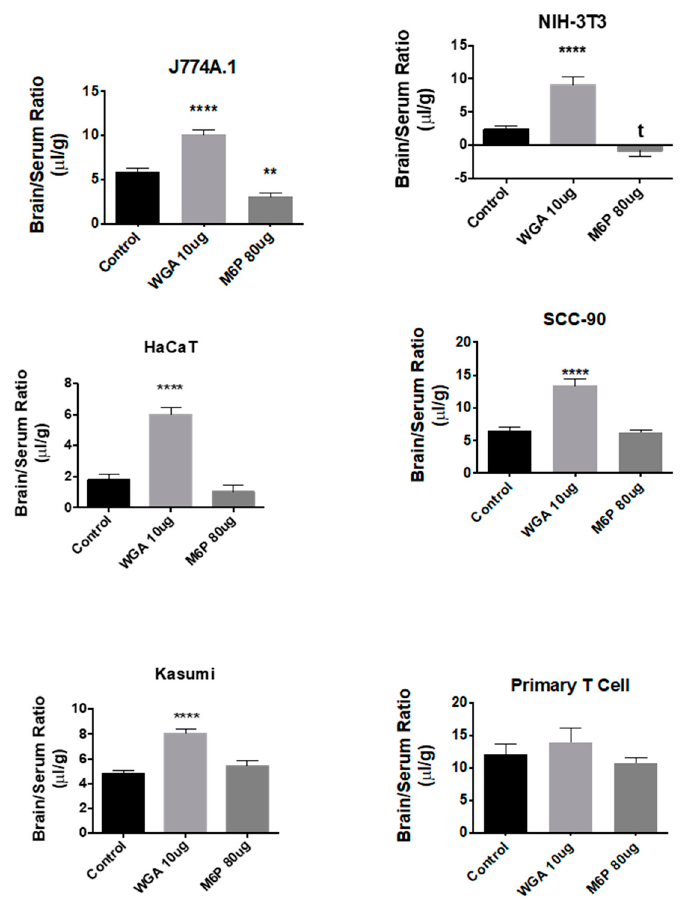
Figure 7. Effects of WGA and M6P on exosome uptake by whole brain. Shown are data for 5/10 tested exosome populations in which WGA significantly enhanced uptake. M6P inhibited uptake of 1/10 exosome populations tested (see J774A.1). Neither WGA nor M6P had an effect on primary T cell-derived exosomes, ** p < 0.01, **** p < 0.001.